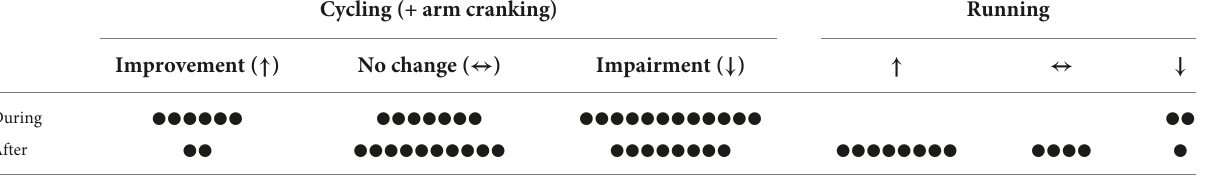
TABLE 4 Summary of impacts of exercise